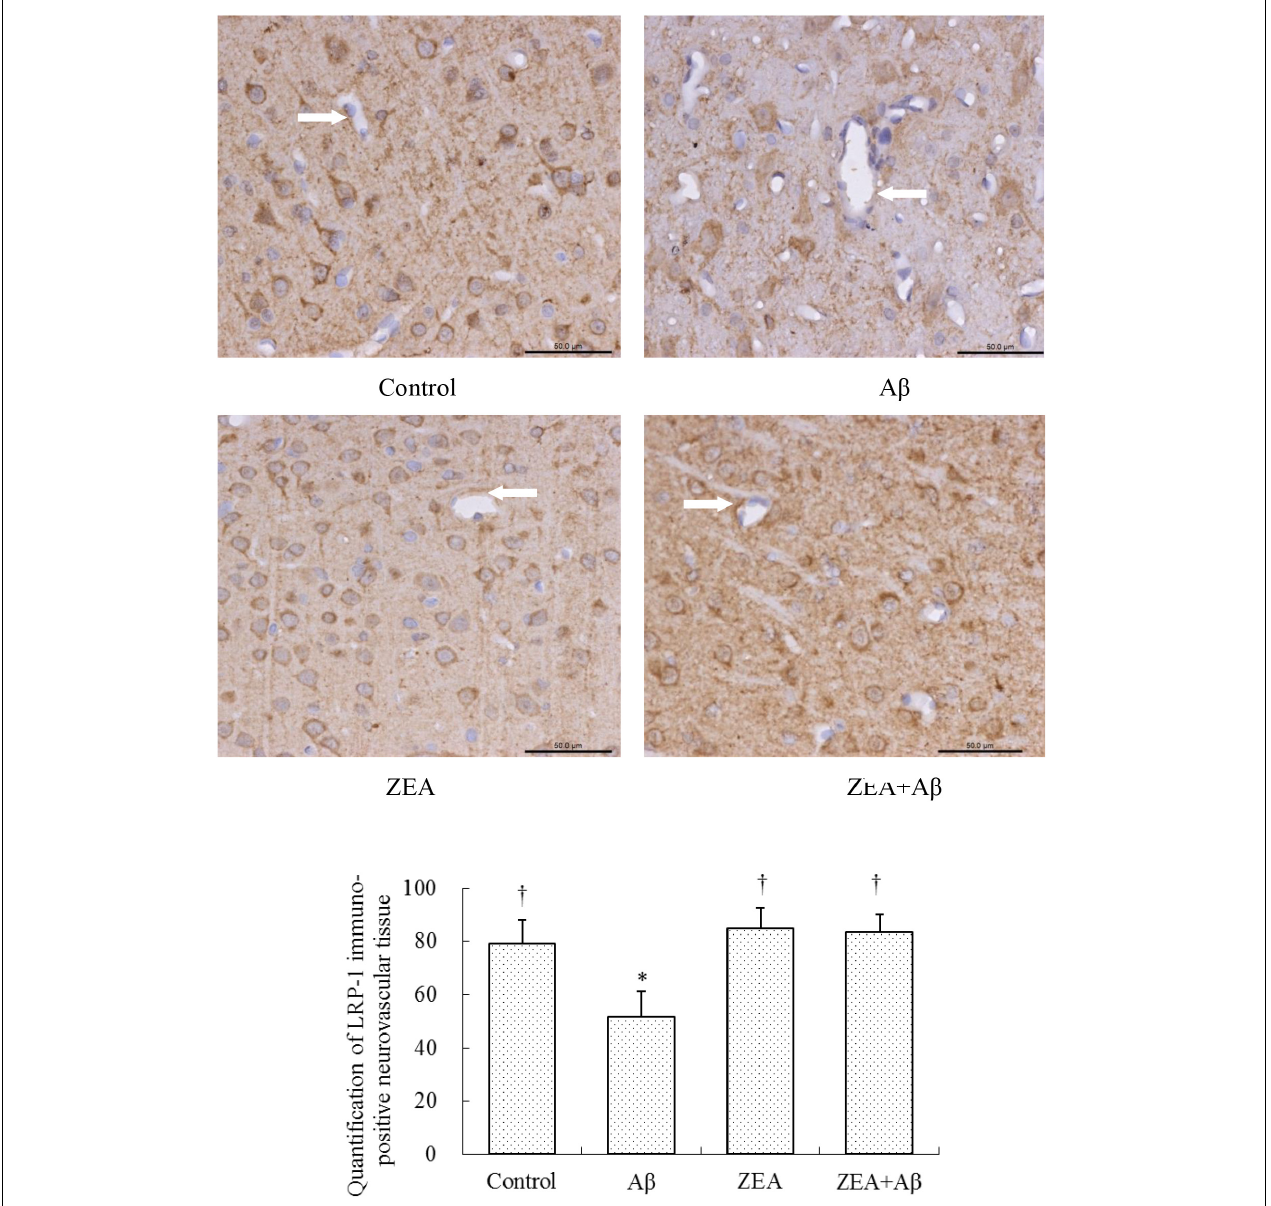
FIGURE 8 | Neuroprotective effects of ZEA on LRP-1 in cerebrovascular tissue of learning and memory impairment rats induced by A β 1–42. Immunohistochemistry was used in the paraffin section of the whole rat brain from four treatment groups mentioned before ( n = 12 per group). All the data were shown as mean ± SD, and analyzed by the one-way ANOVA test [ post hoc (LSD) test]. ∗ Significantly different from the Control group ( p < 0.05). † Significantly different from the A β group ( p < 0.05). Staff gauge showed 50 µ m at the right side of every pictures’